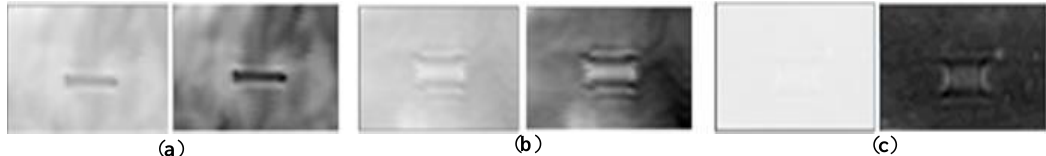
Figure 18. Original (left) and enhanced (right) images of notch 1 under the 2 mm-thick rubber layer, obtained at three standoff distances: ( a ) 0.1 mm, ( b ) 0.25 mm, and ( c ) 4 mm.